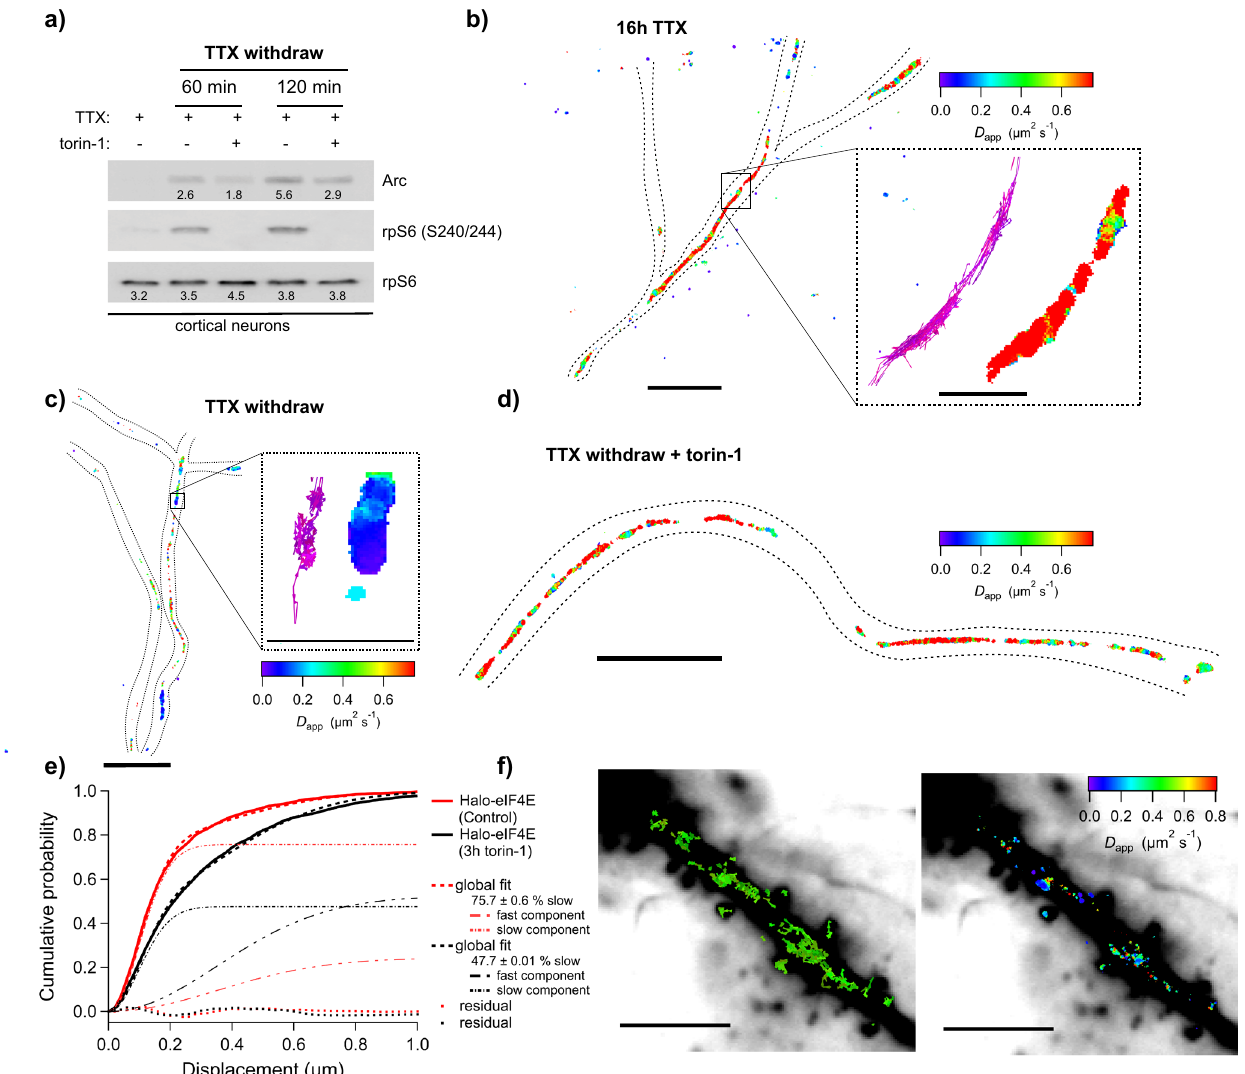
Fig.5|Single-particletrackingofHalo-eIF4Einprimaryhippocampalneurons. Rat hippocampal neurons were activated with TTX withdrawal with or without 250nM torin-1. a Total cell lysates were analyzed by western blotting with the antibodiesindicatednexttothecorrespondingblot( n =2). b Diffusionheatmapof Halo-eIF4Etrajectoriesobtainedininactivatedneurons(16hTTX)ataframerateof 100Hz (with a dotted neuronal outline, scale bar: 5 μ m. Each point in the image is false ‐ colored according to the mean square displacement calculated over all dis- placementsoriginatinginacircle( r =80nm).Inset:Trajectoriesandcorresponding diffusion heat map (scale bar: 1 μ m). c Diffusion map of Halo-eIF4E of activated neurons after TTX withdrawal (scale bar: 5 μ m). Inset: Trajectories and corre- sponding diffusion heat map (scale bar: 1 μ m). d Diffusion speed of Halo-eIF4E in neurons treated with 250nM torin-1 (red colors) (scale bar: 5 μ m). e Single particle tracking was recorded at a frame rate of 200Hz. The cumulative distribution function (CDF) of allsingle-molecule displacements for Halo-eIF4Eis shifted to the